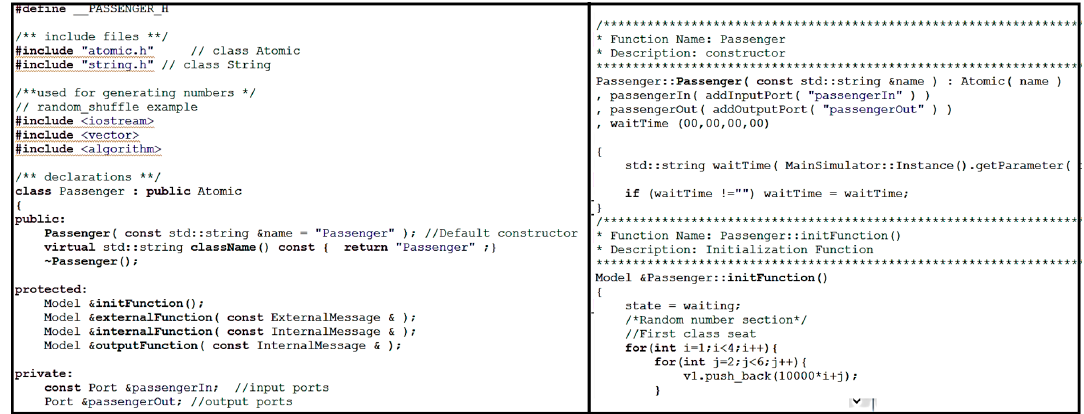
Figure 20. Passenger generator header and source file (C++).